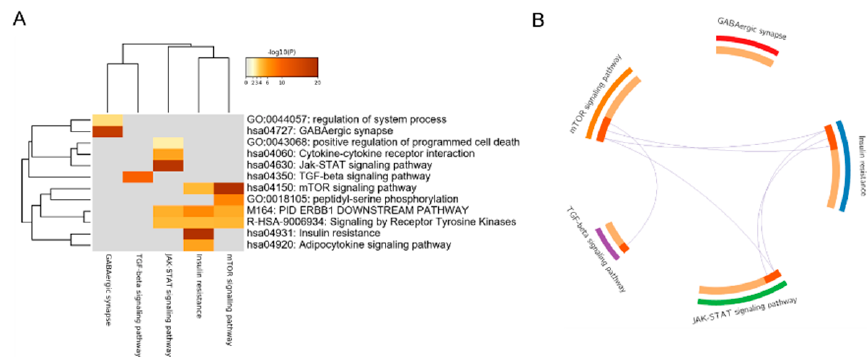
Figure 2. Analysis of five growth-related enrichment pathways. ( A ) Heatmap of enriched terms across enriched genes of the five pathways, colored by p -values. ( B ) Overlaps among the enriched genes of the five pathways at the gene level, in which purple curves link the identical genes. The inner circle represents gene lists, in which hits are arranged along the arc. Genes that hit multiple lists are colored in dark orange, whereas genes unique to a list are shown in light orange. The core PPI network of the enriched DEGs in the five signaling pathways was generated by Metascape and visualized by Cytoscape. The network was composed of 21 nodes, including a transcription factor BCL2 like 1 ( BCL2L1 ) (Figure 3). Subsequently, MCODE analysis showed only a single sub-network in the PPI network representing the core of the entire network. It consisted of STAT3 , cyclin-dependent kinase inhibitor 1A ( CDKN1A ), ribosomal protein S6 kinase alpha-3 ( RPS6KA3 ), tyrosine-protein kinase SRC proto-oncogene ( SRC ), and mitogen-activated protein kinase 9 ( MAPK9 ). These genes are involved in the cell proliferation, apoptosis, and animal growth performance such as feed intake.